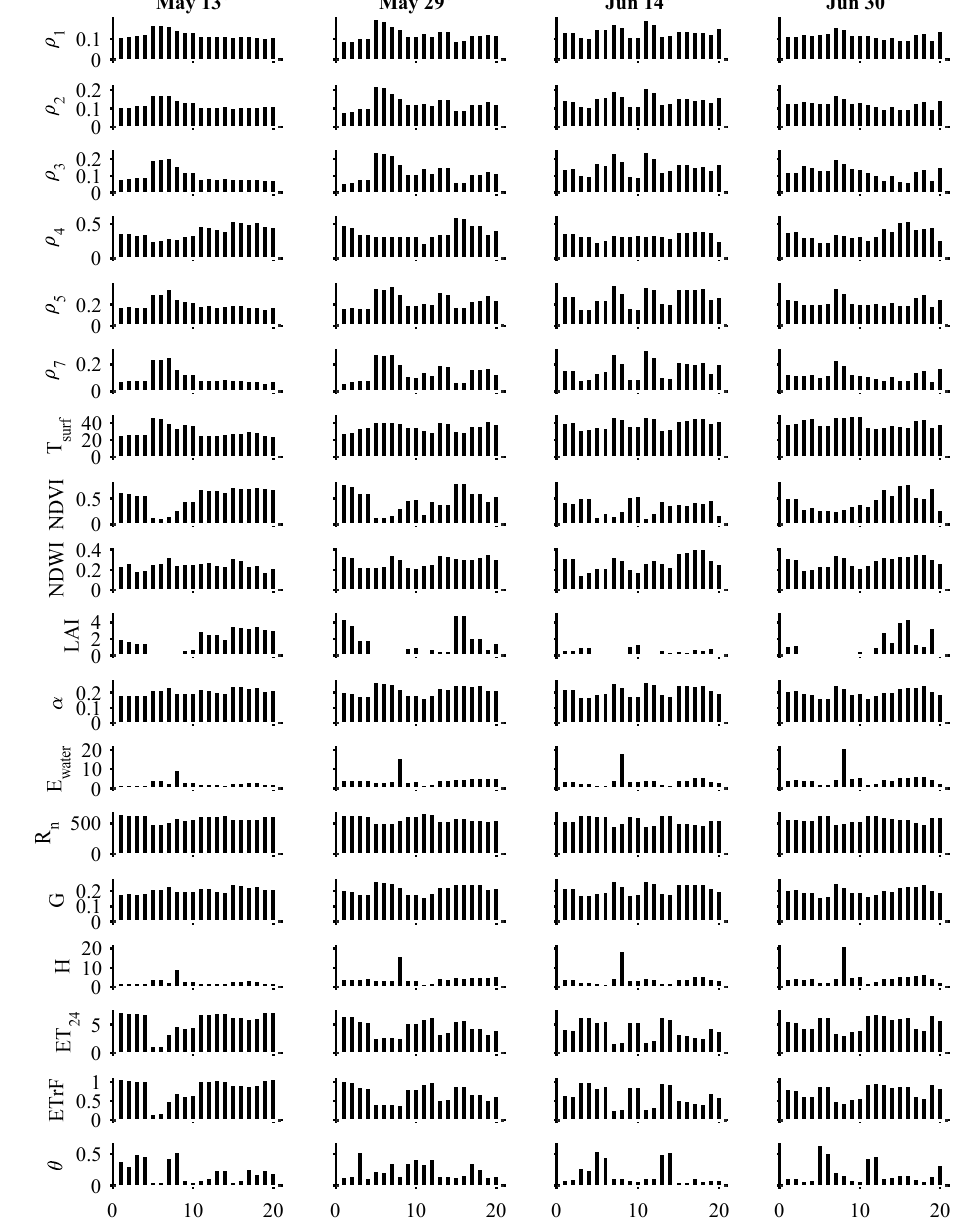
Figure 2. Measured surface soil moisture (bottom row) and corresponding Landsat indices and metric energy balance products (upper rows) for the four Landsat overpass dates considered in the study.